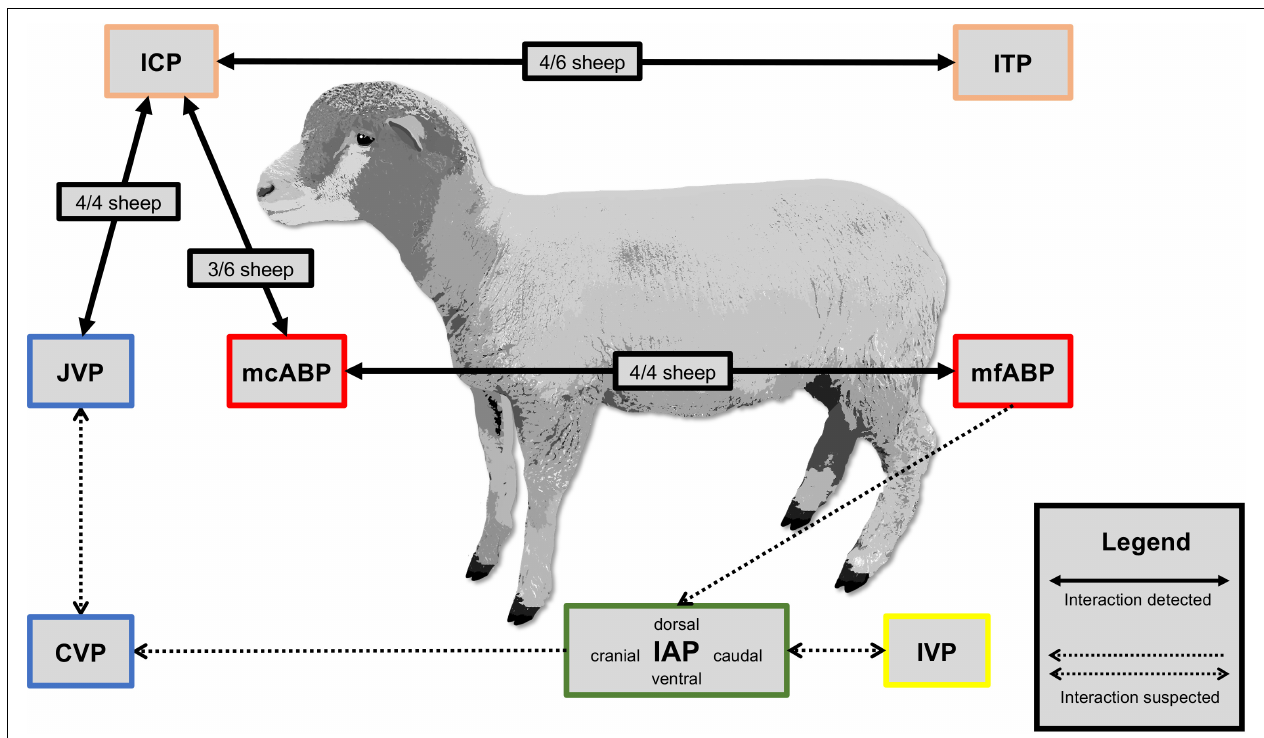
FIGURE 4 | Pressure correlation. Visualization of detected and suspected body compartment interactions between intracranial pressure (ICP), intrathecal pressure (ITP), mean carotid arterial pressure (mcABP), mean femoral arterial pressure (mfABP), jugular venous pressure (JVP), central venous pressure (CVP), intravesical pressure (IVP), and intra-abdominal pressure (IAP) measured during a baseline of 10